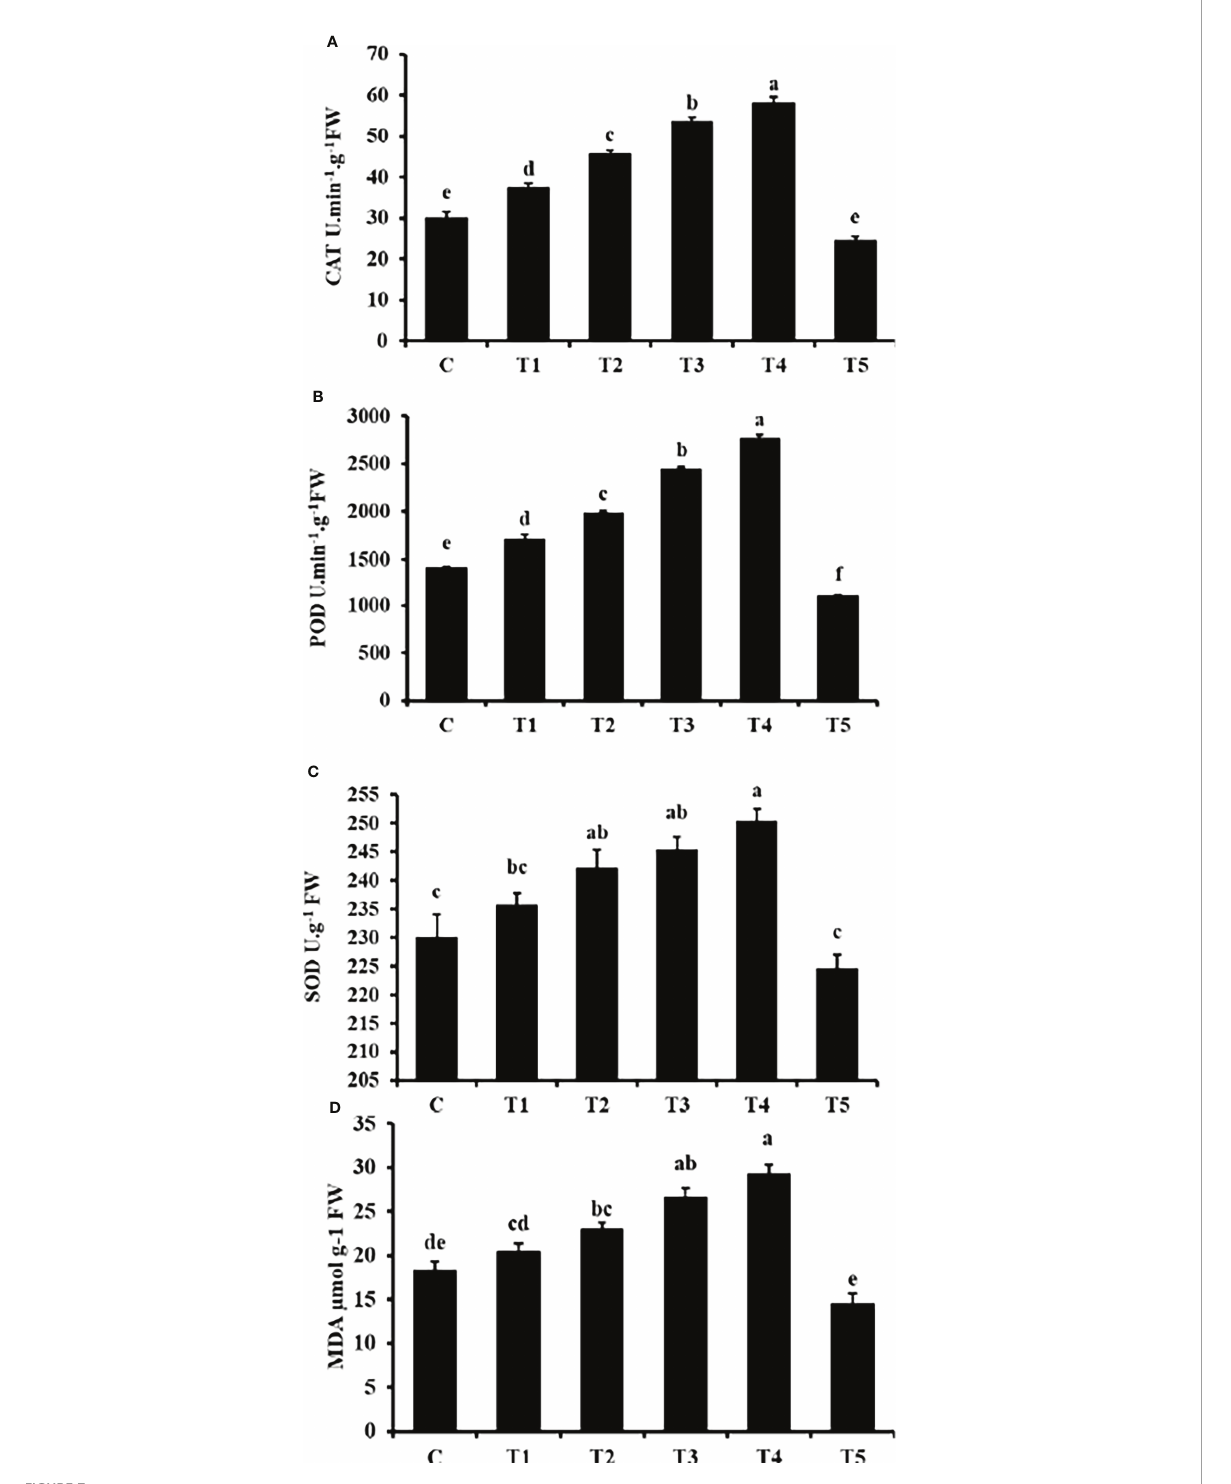
FIGURE 7 Effects of different GO NPs treatments on mungbean CAT (A) , POD (B) , SOD (C) activities and MDA (D) content. The error bars represent the standard error of means. Different letters denote statistically signi fi cant differences between treatments as evaluated by the Tukey ’ s Multiple range test at the P < 0.05 level. C= without GO NPs application (control); T1= 300 mg/L; T2= 600 mg/L; T3= 900 mg/L; T4= 1200 mg/L; T5= 1500